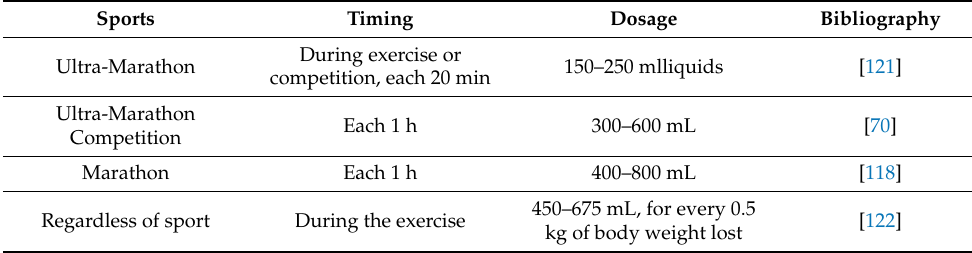
Table 7. Fluid intake during exercise.